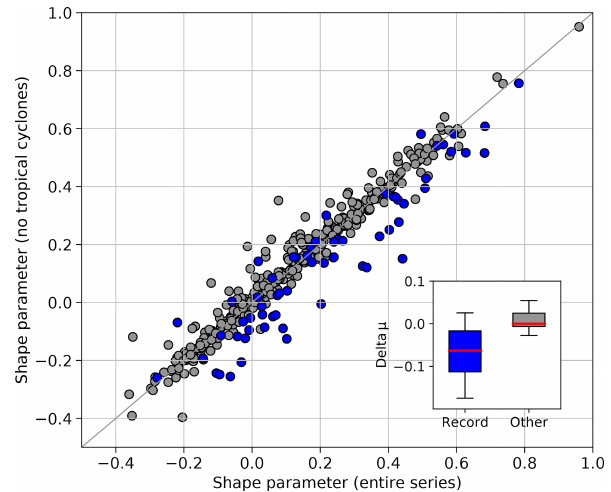
Figure 10. Scatterplot of the shape parameters for the entire se- ries versus the series with annual flood peaks caused by tropical cy- clones removed. Blue dots highlight the stations with record floods that are caused by tropical cyclones (see Fig. 1 for locations). The insert boxplot shows the differences of the shape parameter (series with tropical-cyclone flood peaks removed minus the entire series) for stations with (blue) and without (grey) tropical-cyclone-induced record floods.